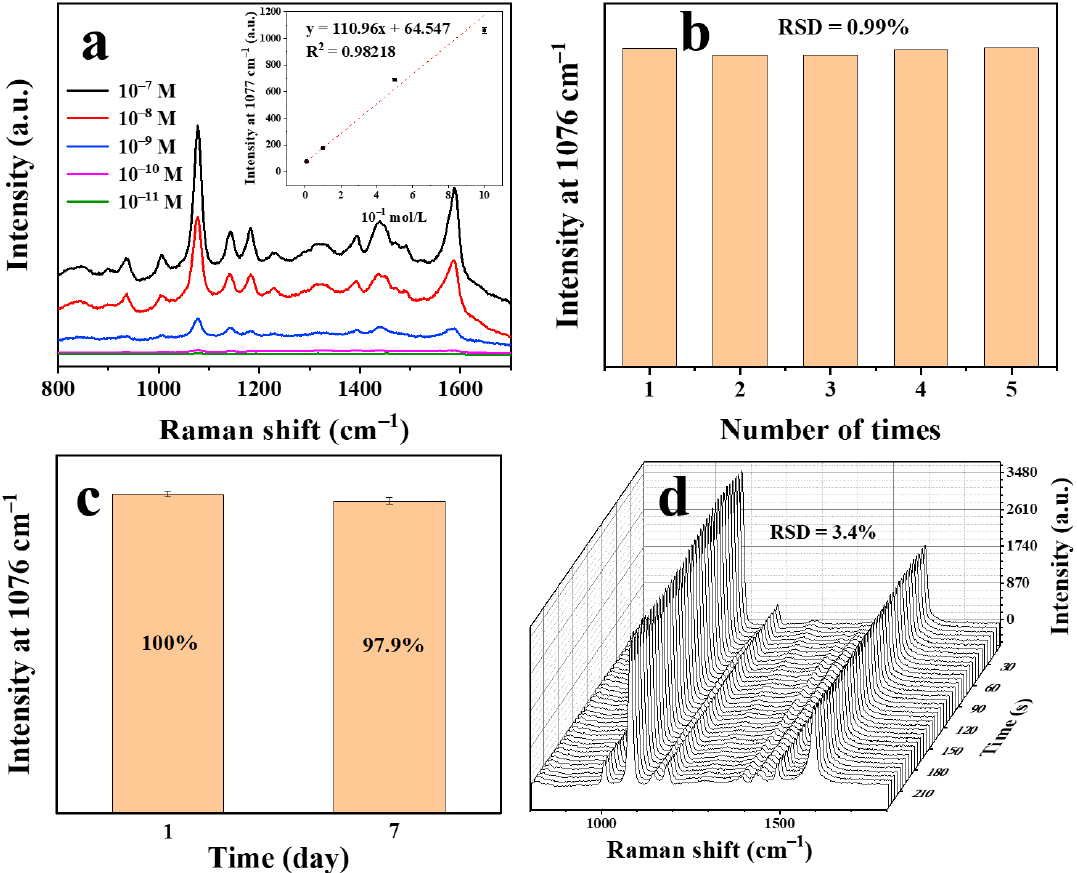
Figure 5. SERS spectra of p -aminothiophenol on silver nanowire membranes treated by 15 CV cycles at 20 °C ( a ) (Inset: the calibration curve of the p -aminothiophenol (PATP) detection). Reproducibility of the CV-treated silver nanowire membranes ( b ). Stability of the CV-treated silver nanowire membranes in air ( c ). Stability of the CV-treated silver nanowire membranes under laser ( d ).